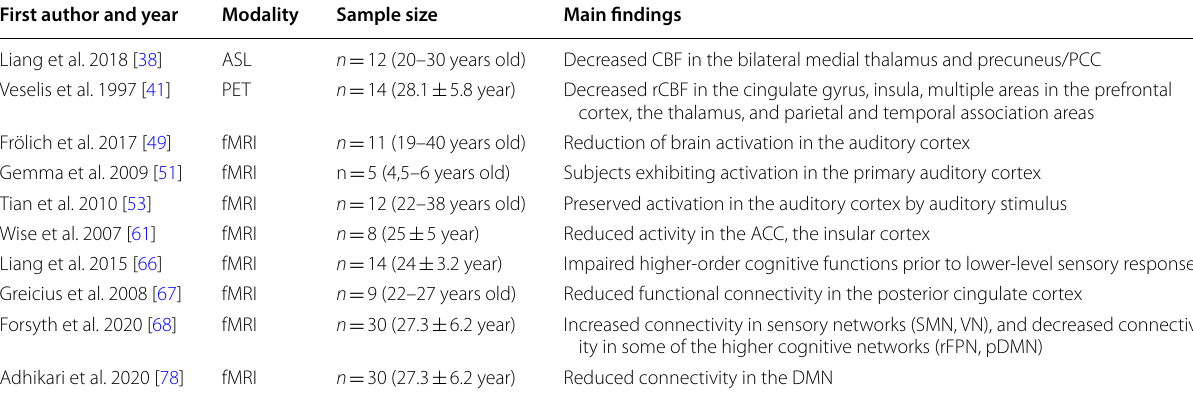
Table 1 Neuroimaging studies during midazolam‑induced